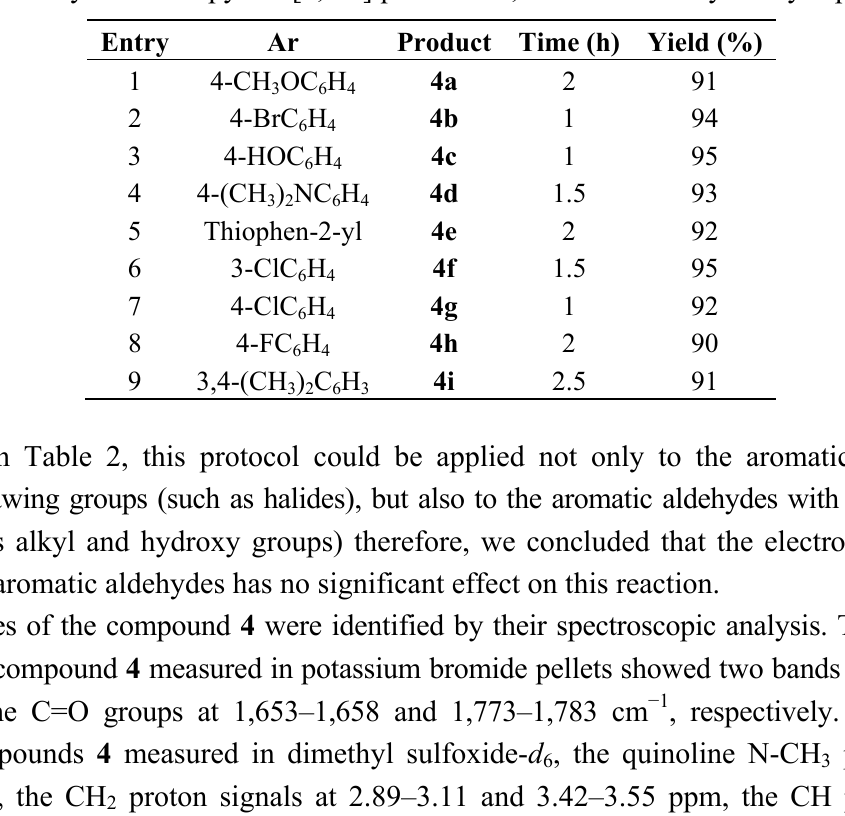
Table 2. Synthesis of pyrano[3,2- c ]quinoline-2,5-diones 4 catalyzed by L